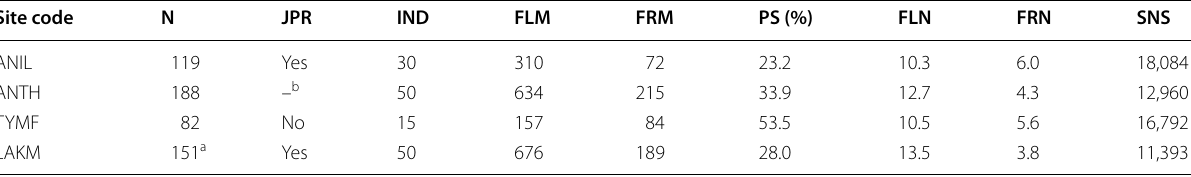
Table 1 Demographic parameters of the studied